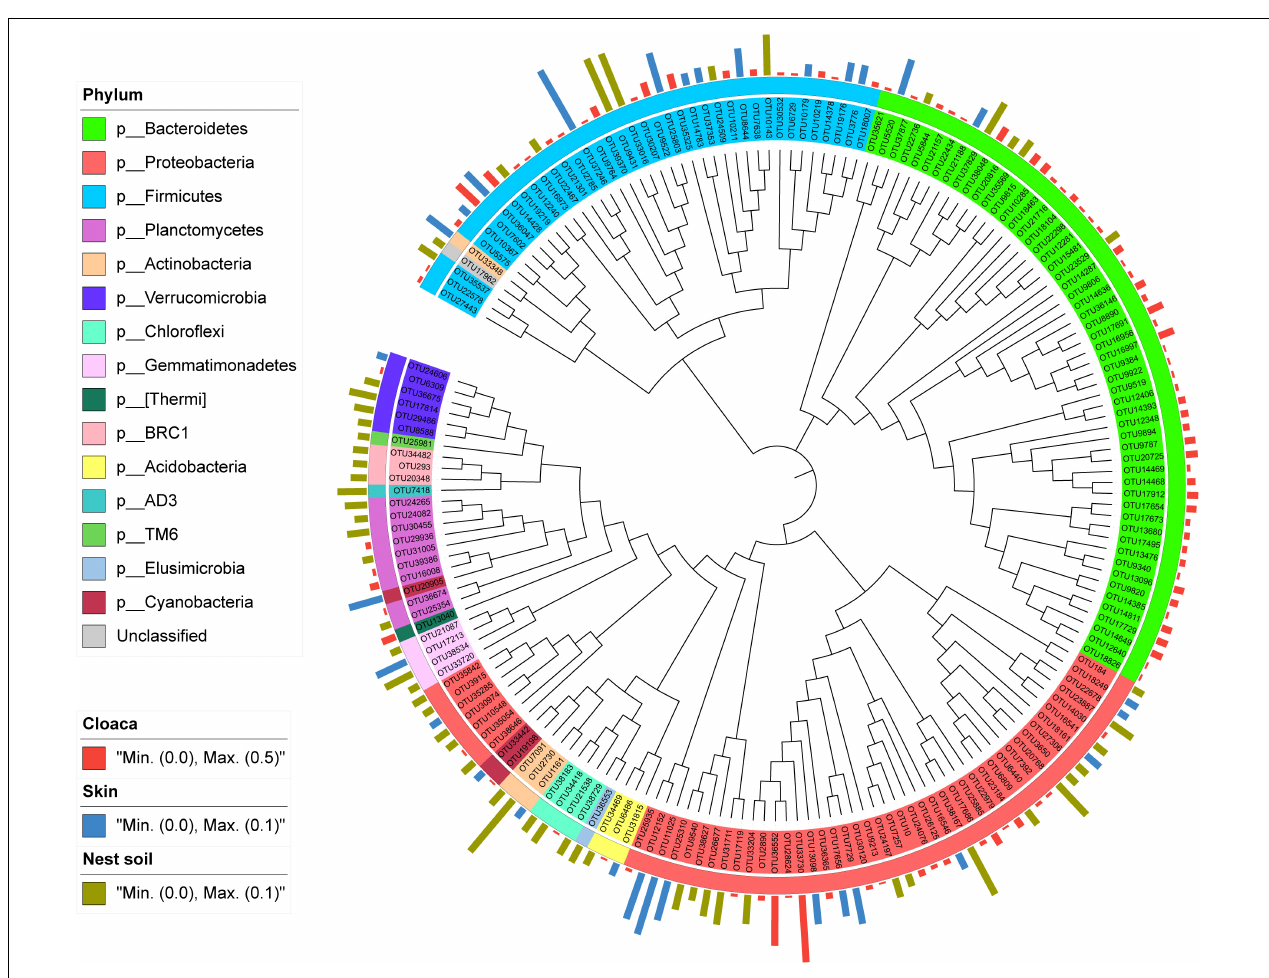
FIGURE 7 | Phylogram and relative abundance of eggshell bacterial communities specifically associated with the three main sources. Branch length is not proportional to the genetic distance. The taxonomic affiliation at phylum level of each specialist OTU is indicated by the color range in the left panel and within the tree. The relative abundance of species in eggshell is indicated in bars outside of the tree, with different colors representing different